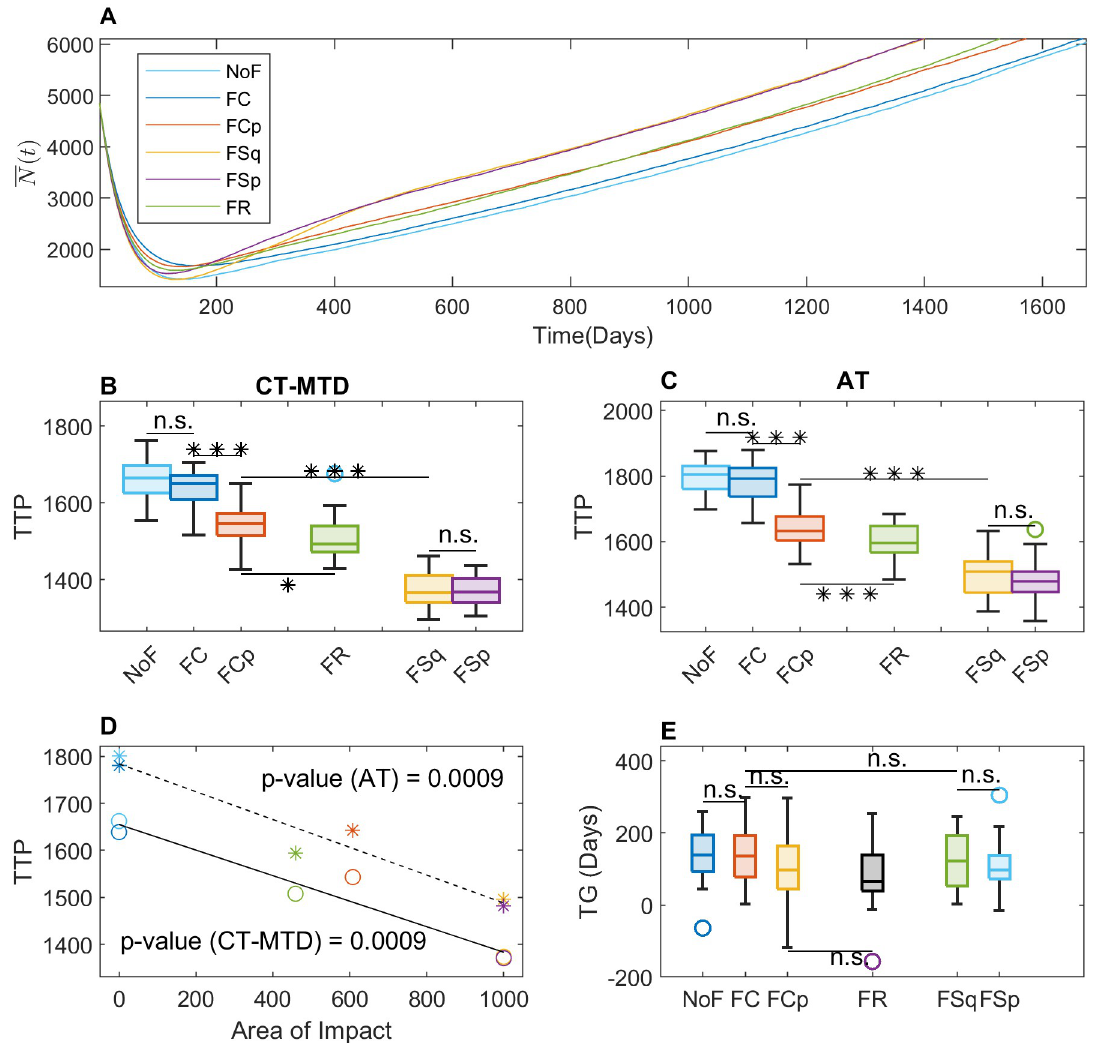
Fig 9. Consequences of CAF-mediated resistance with clumped initial R-cell distribution. ( A ) The time evolution of the average of the total cell population ( � N ð t Þ ) in the 30 simulations is shown for CT-MTD for all types of fibroblast configurations. NoF: no fibroblast, FC: fibroblast overlapping with the R-cell clump at the center of domain, FCp: fibroblast partially overlapping with the R-cell clump at the center, FSq: fibroblast completely surrounding the R-cell clump. FSp: fibroblast over a “L” shaped region, partially surrounding the R-cell clump, FR: fibroblast clumps randomly placed in the domain. ( B ) Boxplot of the time to progression (TTP) in the 30 realizations under CT-MTD. ( C ) Boxplot of the time to progression (TTP) in the 30 realizations under AT is shown. ( D ) Correlation of TTP with the area of impact is shown. The circles and the asterisks (the colors are similar to the legend in A) show the TTP under CT-MTD and AT respectively. The solid and dashed lines are the respective regression lines (sold line: CT-MTD, dashed line: AT). The p − values for AT and CT-MTD indicate significance of the correlation. ( E ) Time gain (TG) is shown as boxplots for all six types of fibroblast